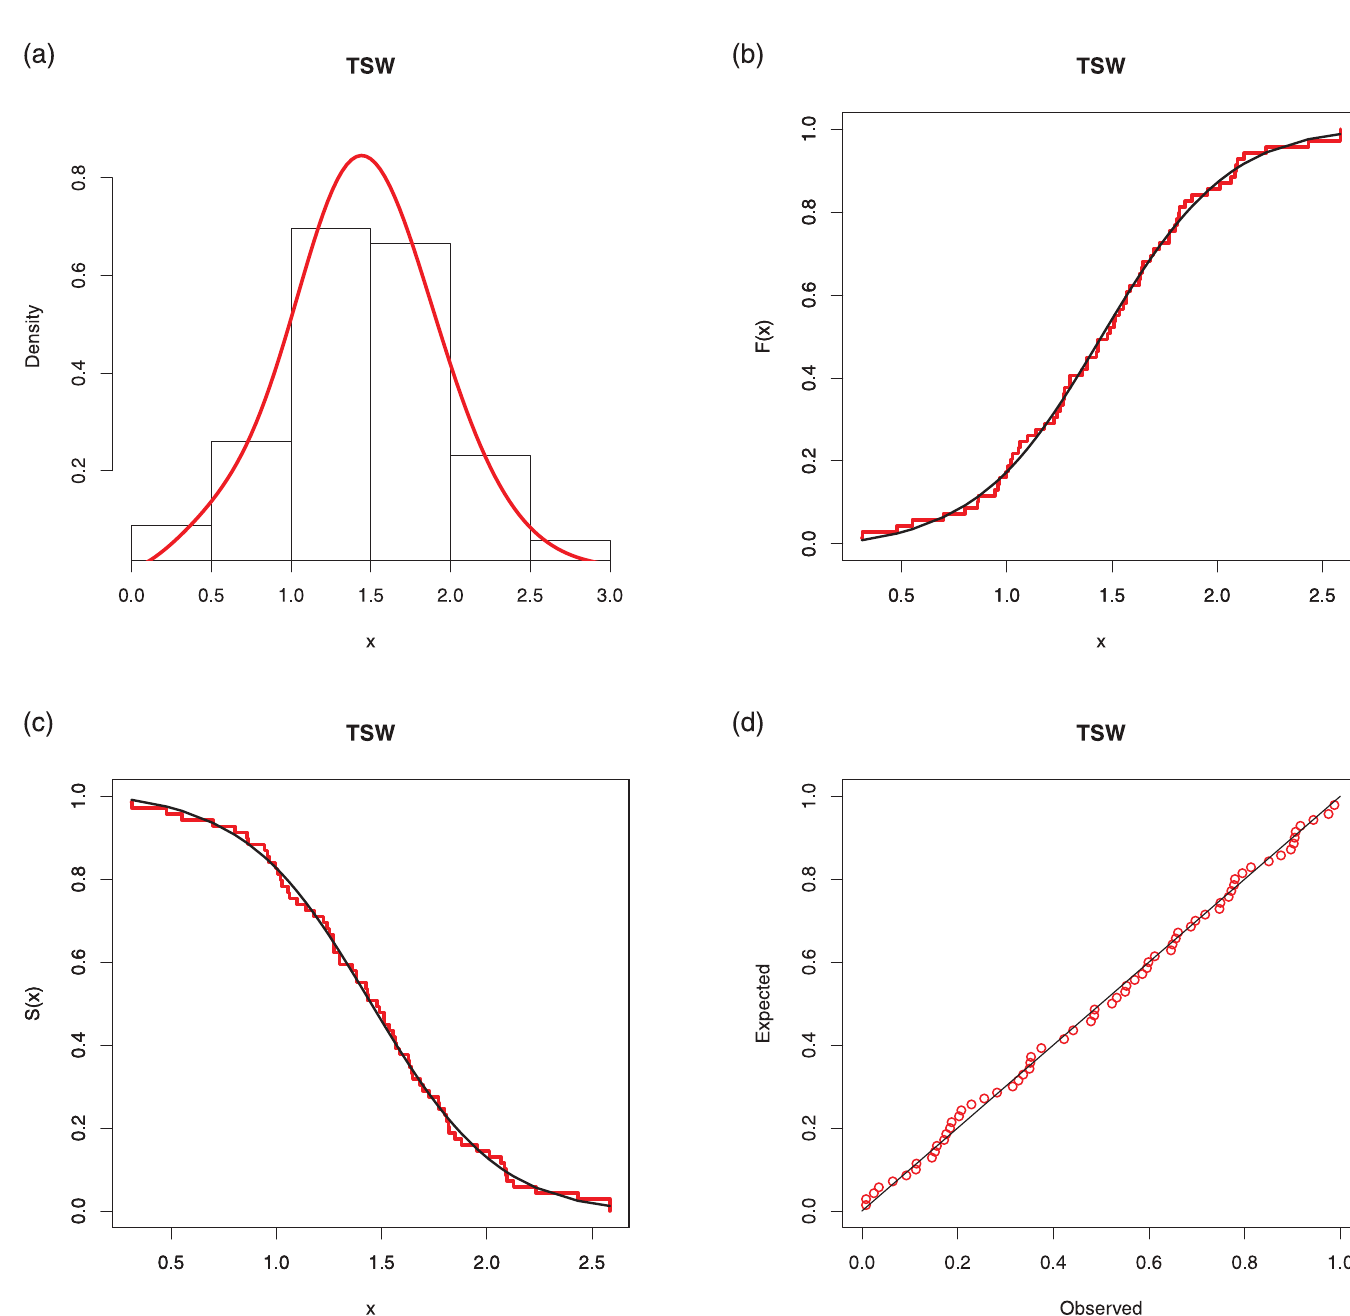
Fig 6. Several fits of the TSW model for the first data set: (a) estimated pdf over the histogram, (b) estimated cdf over the empirical cdf, (c) estimated sf over the empirical sf and (d) P-P plot.